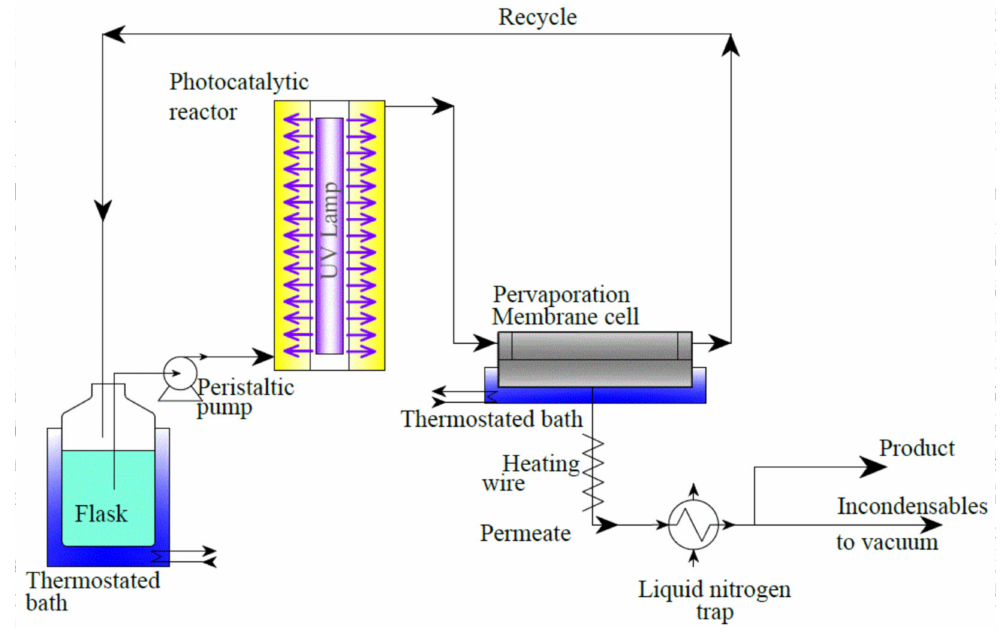
Figure 5. Scheme of the photocatalysis-pervaporation set-up